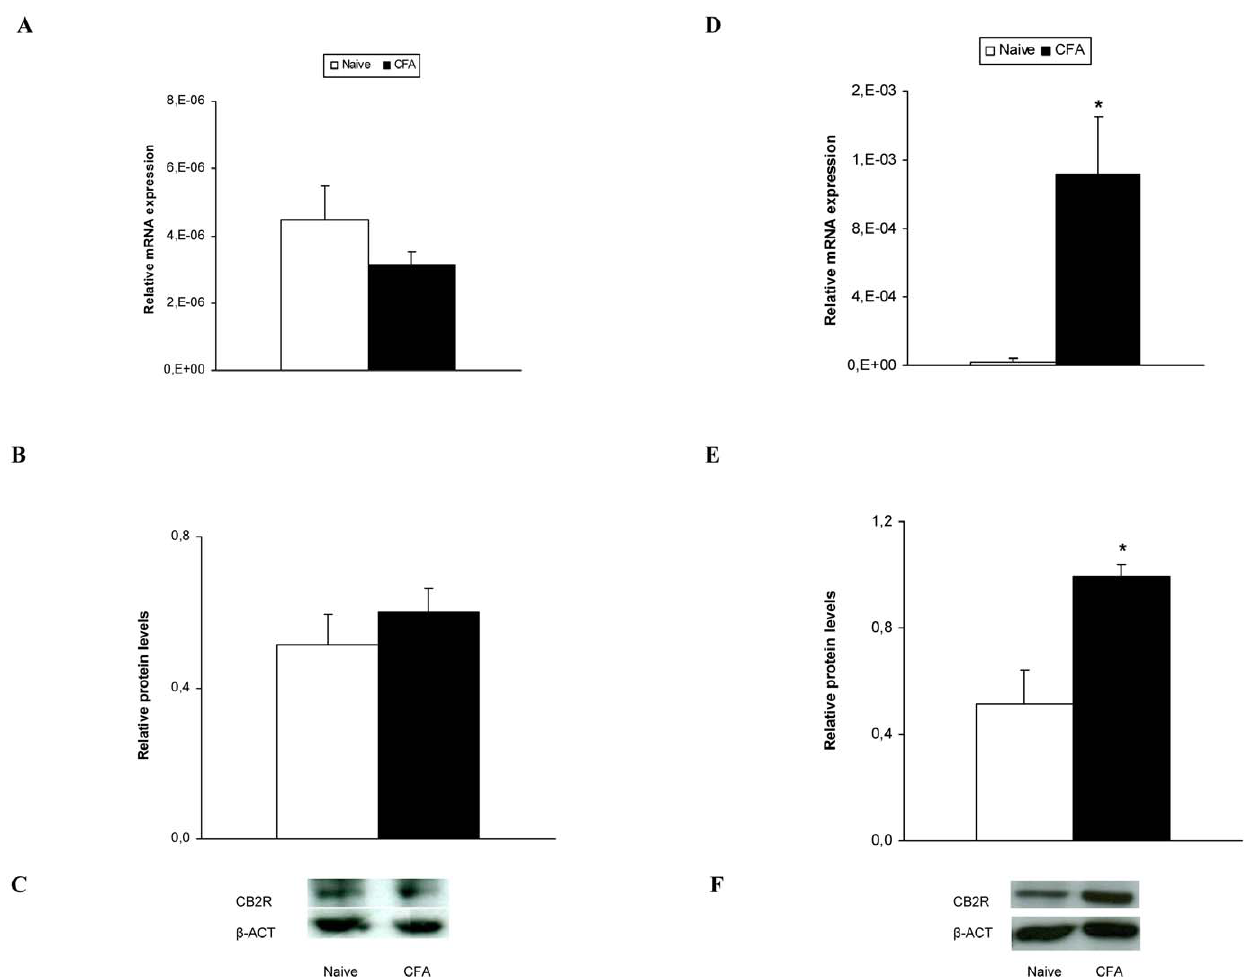
Figure 3. Dorsal root ganglia and paw expression of CB2R. The relative mRNA (A and D) and protein (B and E) expression of CB2R in the ipsilateral side of the dorsal root ganglia (left) and paw (right) from naive and CFA injected WT mice were shown. A representative example of Western blots for CB2R protein (37 kDa) in which b -actin (43 kDa) was used as a loading control is shown in C and F. Data are expressed as mean values 6 SEM; n=4–5 samples per group. * indicates significant differences when compared CFA vs. naı¨ve mice (p , 0.03, Student’s t